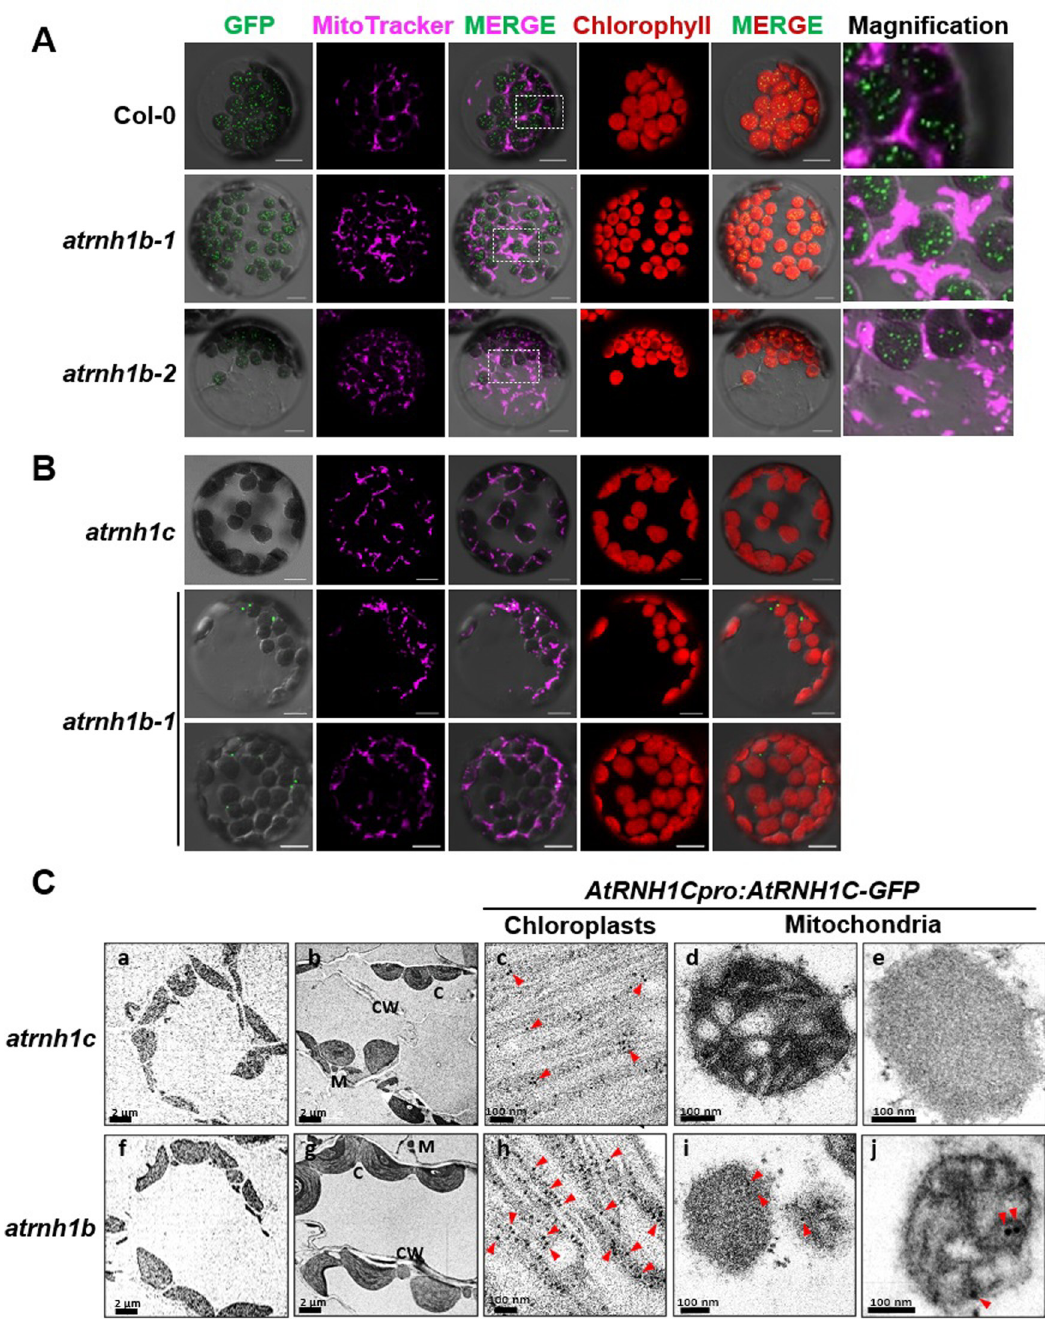
Fig 4. AtRNH1C can localize to mitochondria in the absence of AtRNH1B. (A) Col-0, atrnh1b-1 , and atrnh1b-2 protoplasts were transformed with AtRNH1C-GFP driven under 35S promoter. Green = GFP, magenta = MitoTracker, and red = chlorophyll. White boxes indicate the regions magnified on the right. Scale bars, 10 μ m. (B) Protoplasts from the leaves of AtRNH1Cpro : AtRNH1C-GFP transgenic plants in the atrnh1c and atrnh1b-1 backgrounds. (C) Immunogold labeling detects dual localization event of AtRNH1C in the absence of AtRNH1B. (a and f) Preimmune controls showed no gold labeling in the cells. (b–e) AtRNH1C-GFP signal appeared to be clustered in chloroplast exclusively in AtRNH1Cpro : AtRNH1C - GFP atrnh1c transgenic plants. (g–j) AtRNH1C-GFP signal can be detected in both chloroplast and mitochondria in AtRNH1Cpro : AtRNH1C - GFP atrnh1b transgenic plants. C, chloroplast; CW, cell walll; GFP, green fluorescent protein; M, mitochondrion.